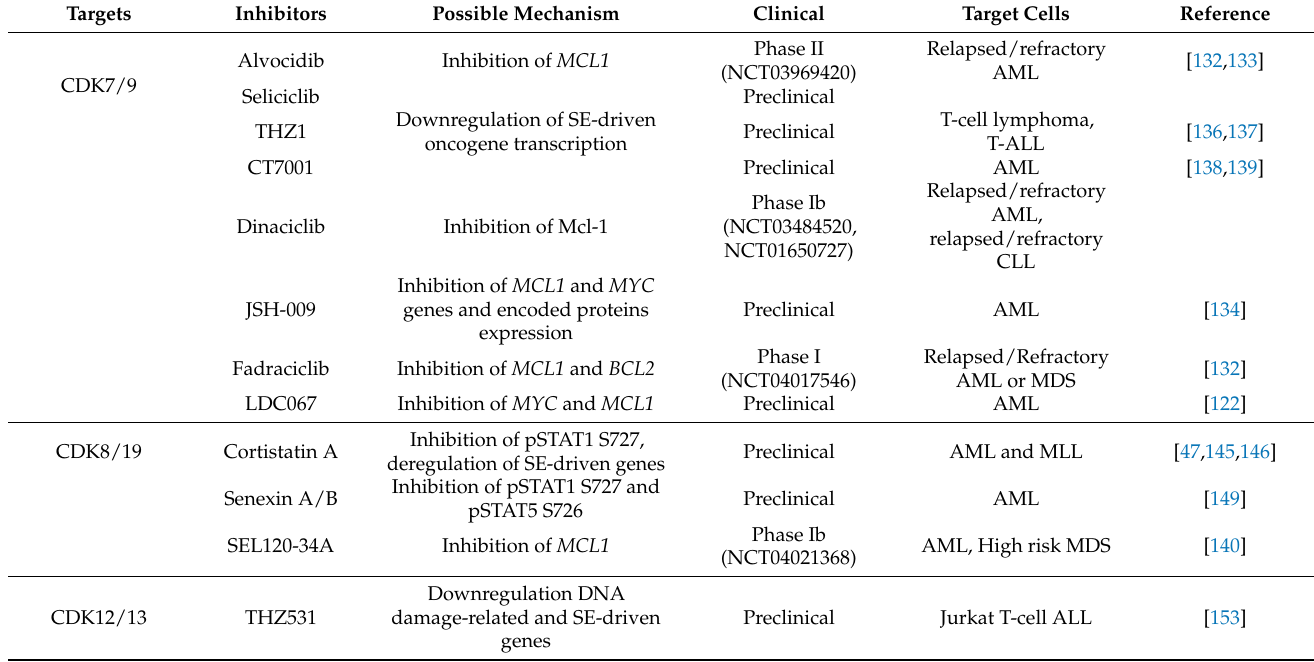
Table 3. List of transcriptional CDK inhibitors: predicted mechanism of antitumor efficacy and the stage of development.